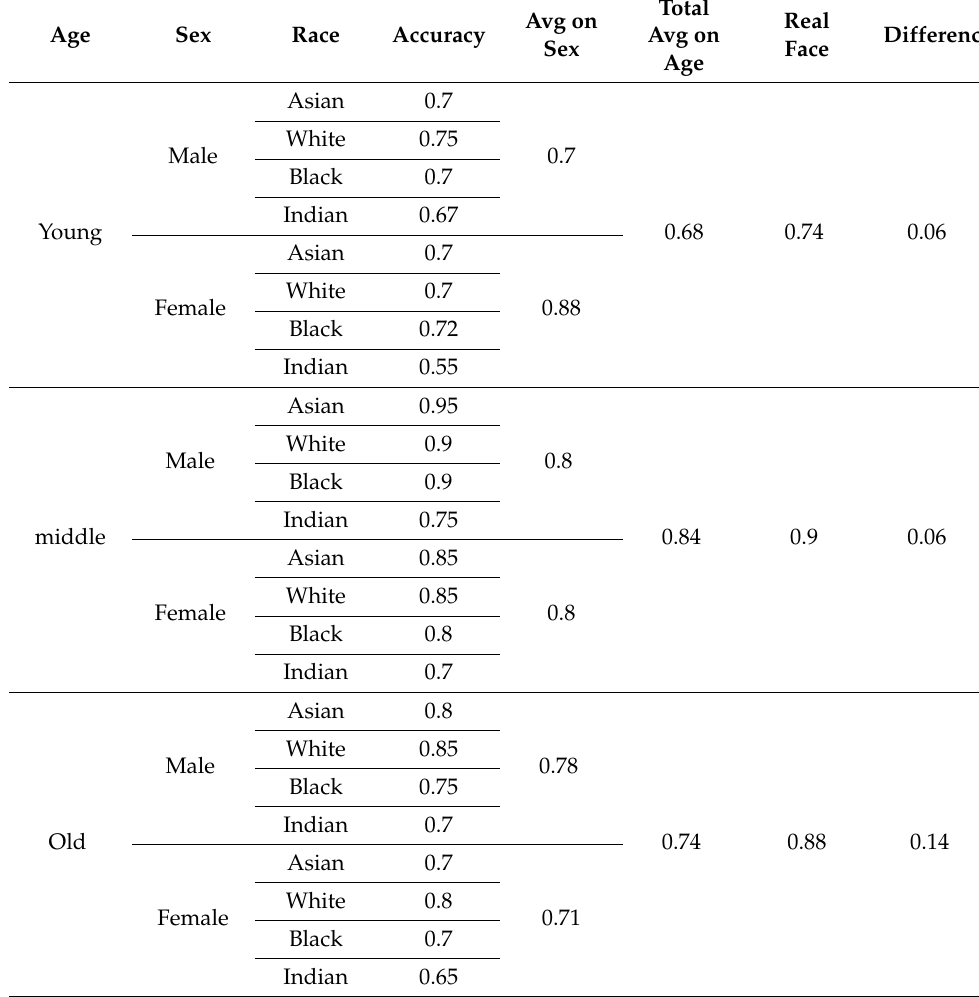
Table 3. Accuracy of a facial recognition model on age recognition for generated and real